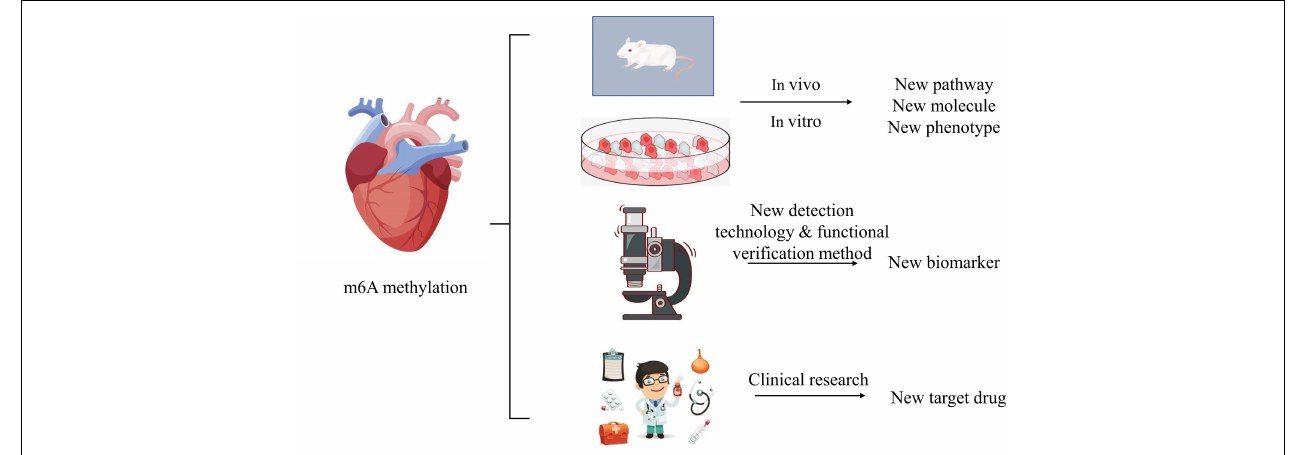
FIGURE 3 | The flow-chart of further research in the field of heart